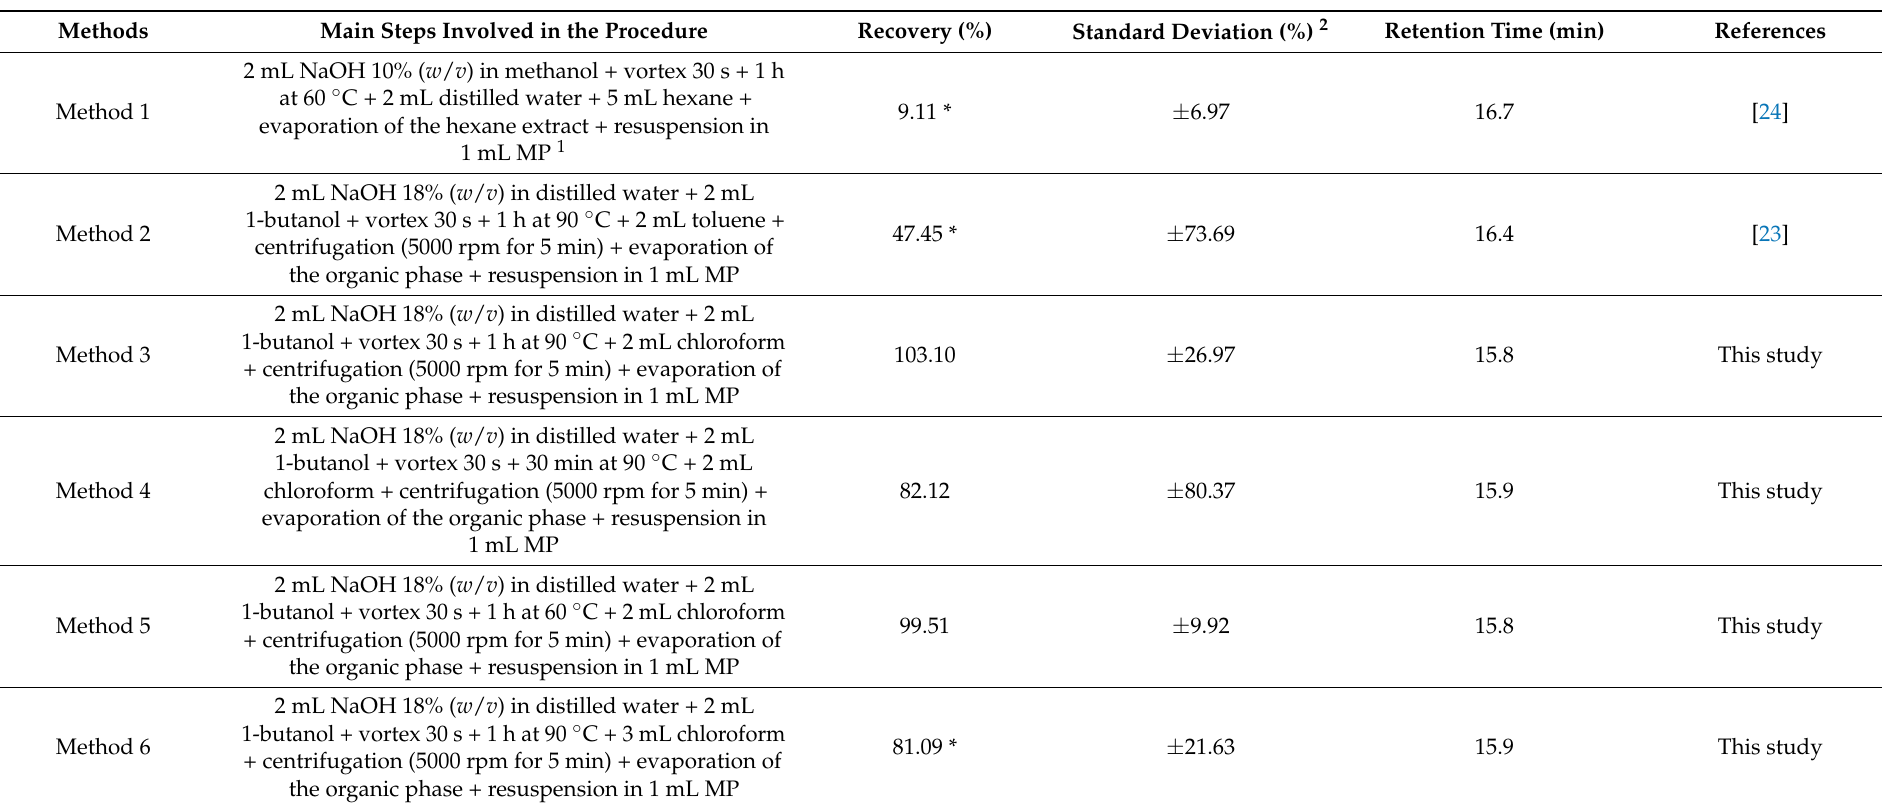
Table 1. Main procedure steps and results of the methods for extraction of mould ergosterol evaluated in this